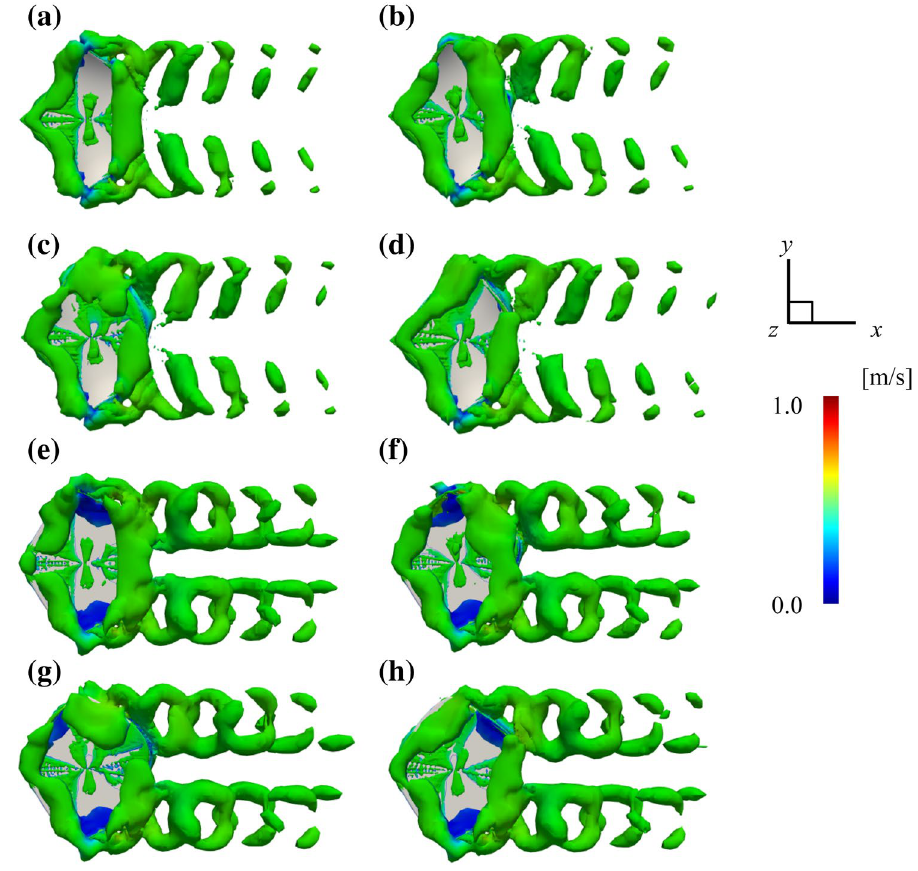
Figure 5. Three-dimensional wake structure of D. acutirostra on ( a ) 0 T difference, ( b ) 0.25 T difference, ( c ) 0.5 T difference, and ( d ) 0.75 T difference at t = 4.98. Three-dimensional wake structure of D. matsubarai on ( e ) 0 T